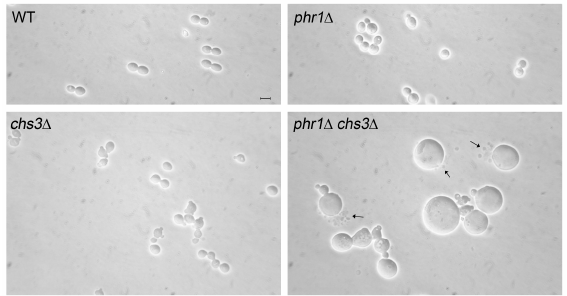
Figure 9. Phenotype of the indicated mutants in liquid YPD-150 mM HEPES, pH 8 at 25 °C (vegetative growth). Cells were sonicated for three cycles of 6 s. The percentages of lysed cells were: WT: 2%, phr1 Δ : 14%, chs3 Δ : 55% and phr1 Δ chs3 Δ : 85%. The arrows indicate fractures of the cell wall and release of cellular material. Bar: 5 μ m. Unpublished results.